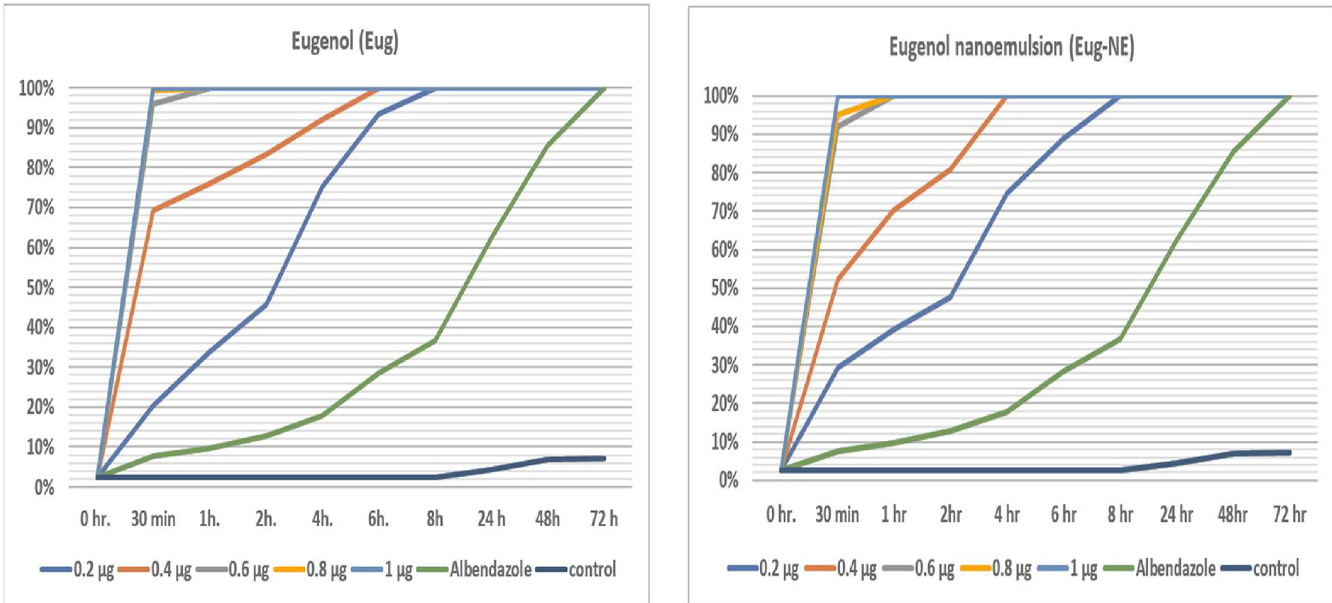
Fig 5. Mortality rate of PCs with various concentrations of Eug and Eug-NE at different exposure periods.